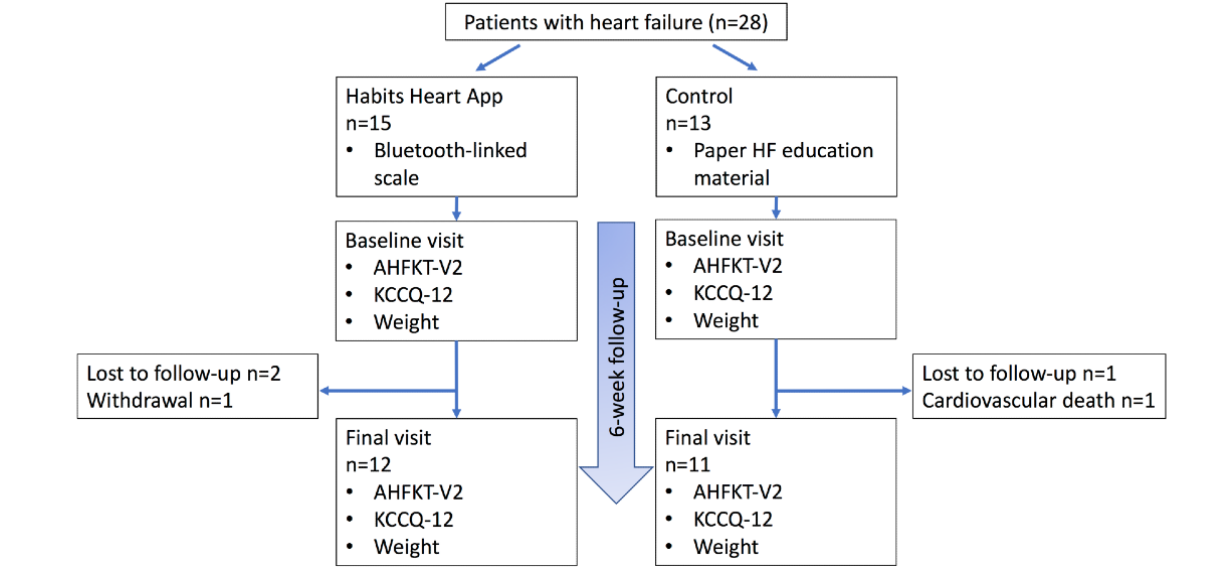
Figure 1. Study flow diagram. AHFKT-V2: Atlanta HF Knowledge Test, Version 2; HF: heart failure; KCCQ-12: Kansas City Cardiomyopathy Questionnaire.